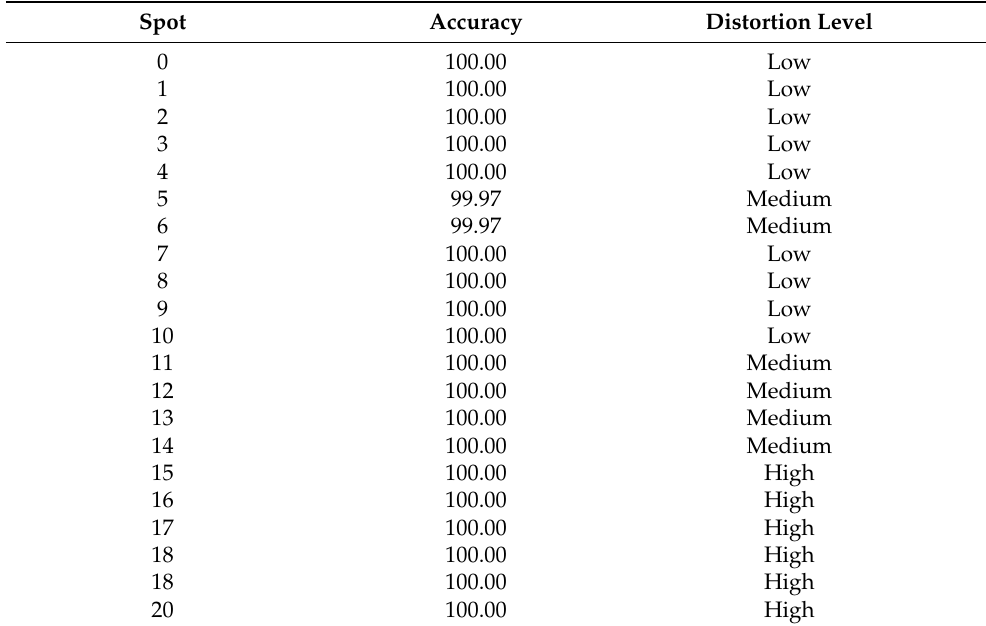
Table 6. Sensitivity analysis of the image distortion for the ETSIT database and the ConvNeXtTiny backbone. Accuracy values per parking spot have been computed to portray the stability of the proposed system.